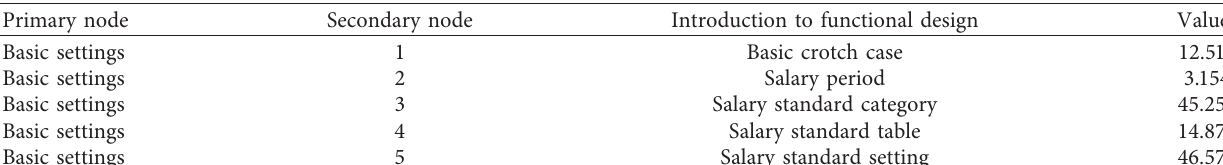
Table 1: Functional design profile.